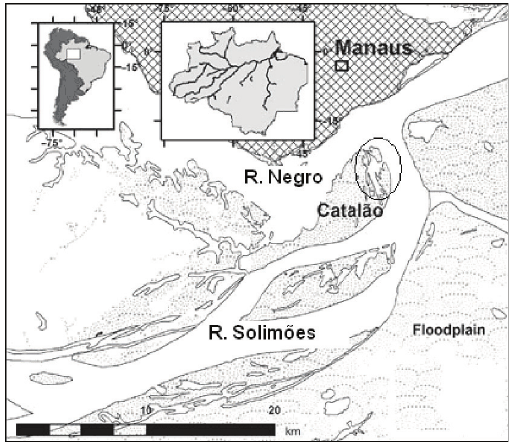
Figure 1. Map of the Amazon floodplain near Manaus, Brazil, showing the location of Lago Catalão (circled area), 3° 10’ 04” S and 59° 54’ 45” W. (Modified from Neves dos Santos et al.,